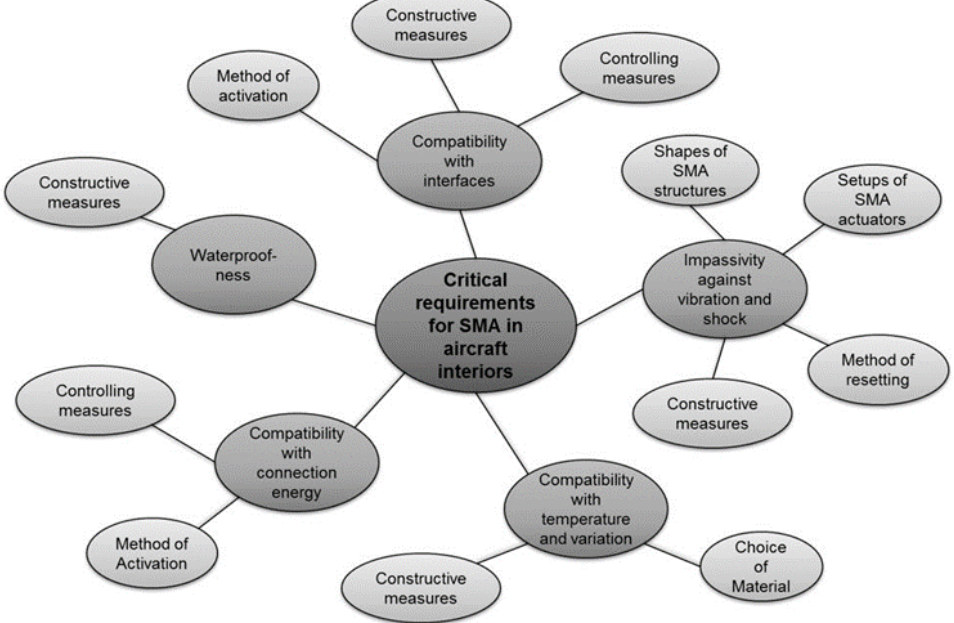
Figure 4. Cluster of critical requirements and influencing SMA specific attributes.